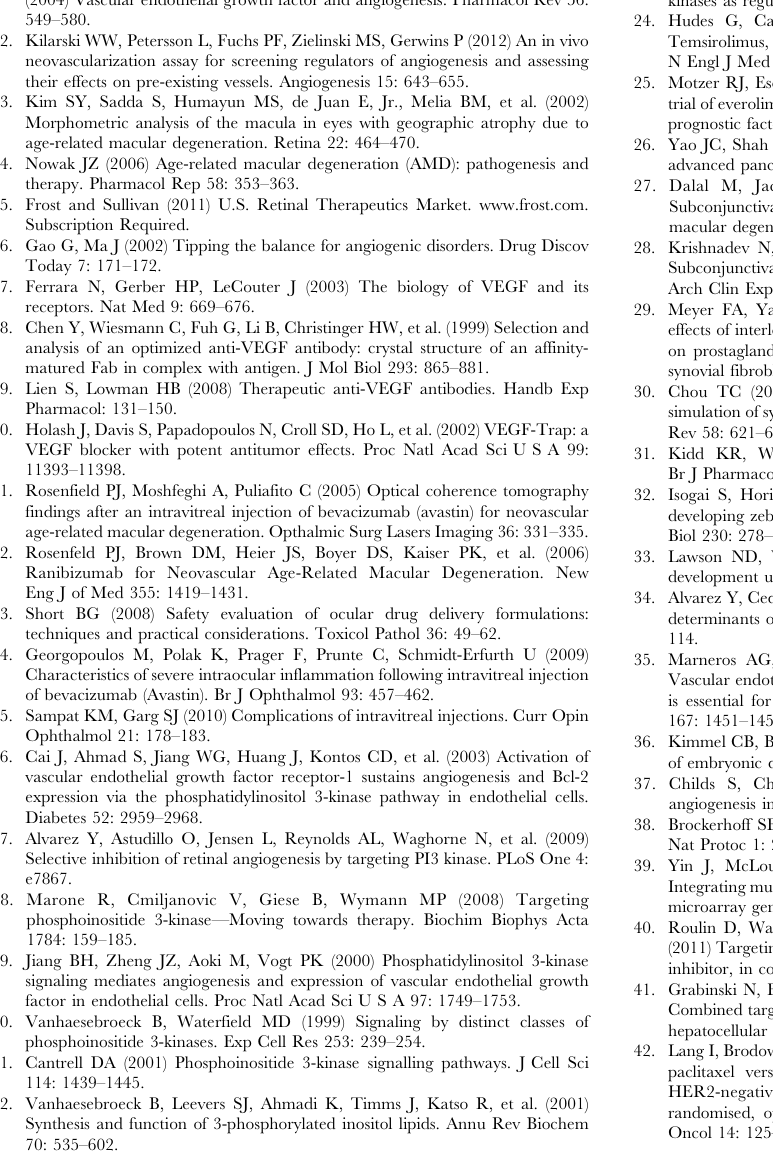
means 6 s.e.m of 4 independent experiments ( n =60–80). *P , 0.05 & **P , 0.01 relative to vehicle control. (TIF) Figure S3 Chemical structures, molecular weight and IC 50 values of screened PI3K/AKT/mTOR pathway inhibitors.